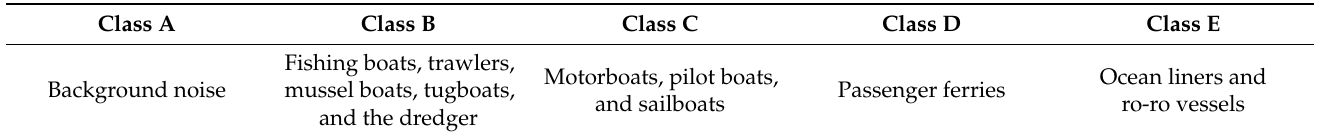
Table 1. A detailed description of the five